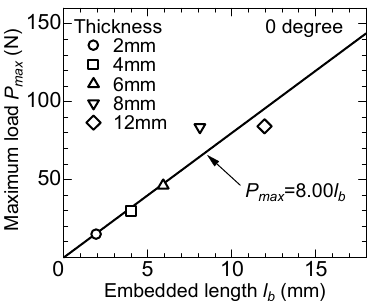
Figure 9. Maximum load versus embedded length (no-inclined angle).